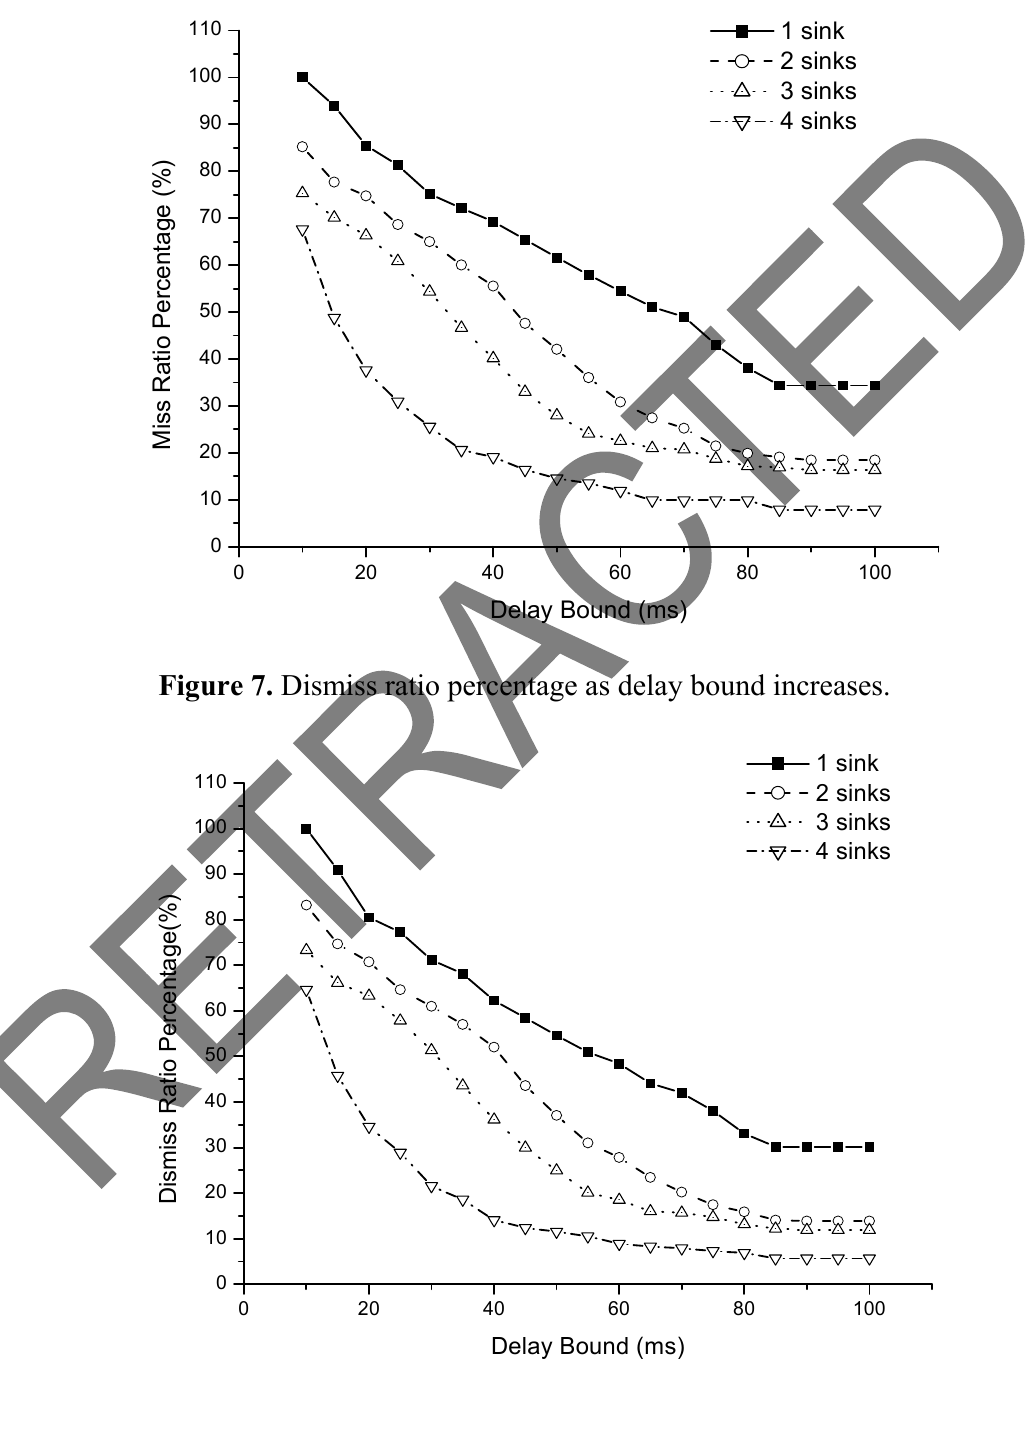
Figure 6. Miss ratio percentage as delay bound increases.